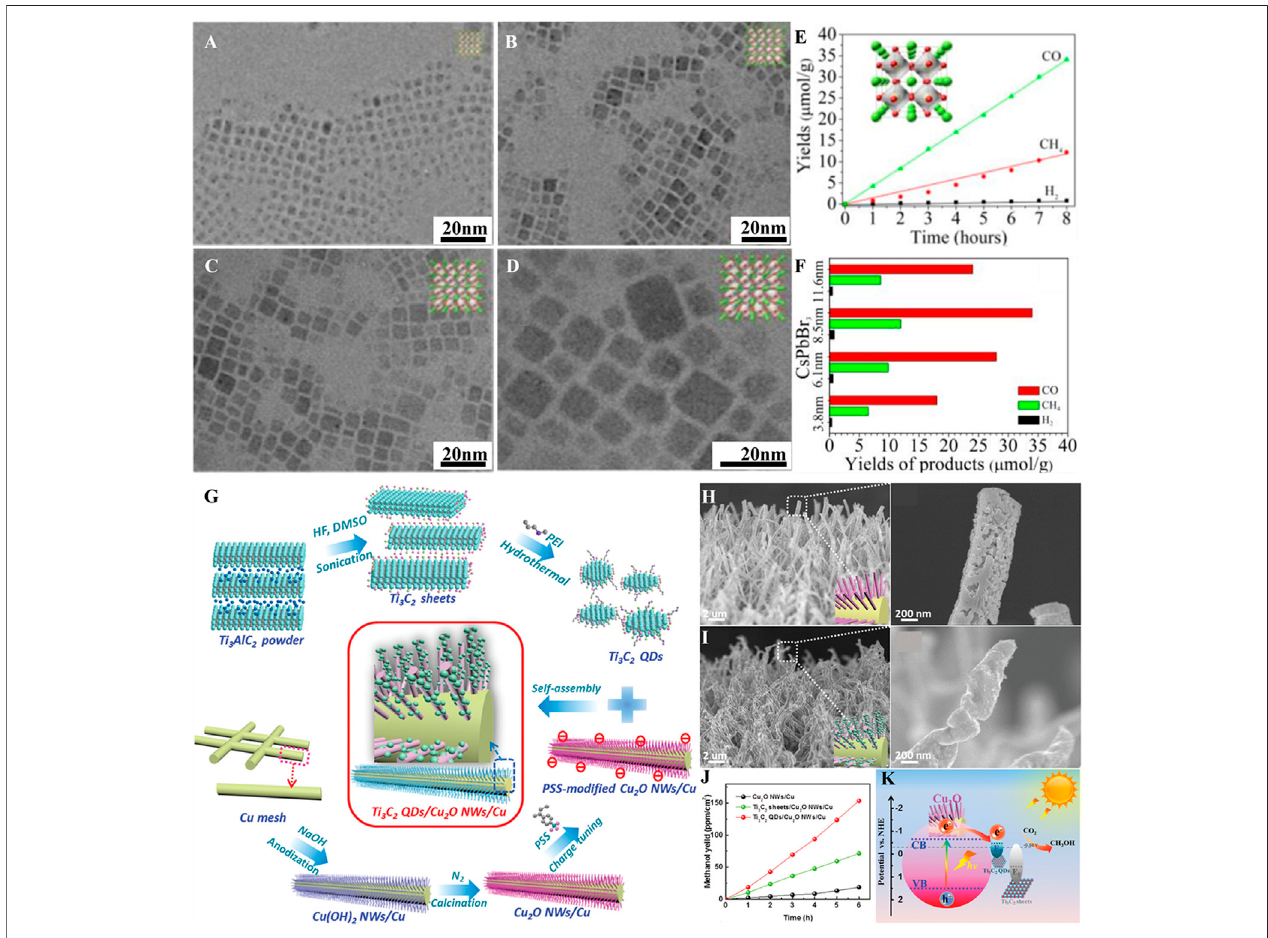
FIGURE2| TEM imagesofCsPbBr 3 QDswithparticle sizesof (A) 3.8 nm, (B) 6.1 nm, (C) 8.5 nm,and (D) 11.6 nm (insetcrystal structures). Photocatalytic CO 2 R for QDs with (E) 8.5 nm CsPbBr 3 QDs and (F) CsPbBr 3 QDs of different sizes (reproduced with permission from (Hou et al., 2017)). (G) Schematic illustration for synthesisofTi 3 C 2 QDsandTi 3 C 2 QDs/Cu 2 ONWs/Cuheterostructure,FE-SEMimagesof (H) Cu 2 ONWs/Cu,(i)Ti 3 C 2 QDs/Cu 2 ONWs/Cuheterostructures, (J) CH 3 OH yield as a function of time, and (K) energy level diagram of Ti 3 C 2 QDs/Cu 2 O NWs/Cu and Ti 3 C 2 sheets/Cu 2 O NWs/Cu heterostructures (reproduced with permission from (Zeng et al.,